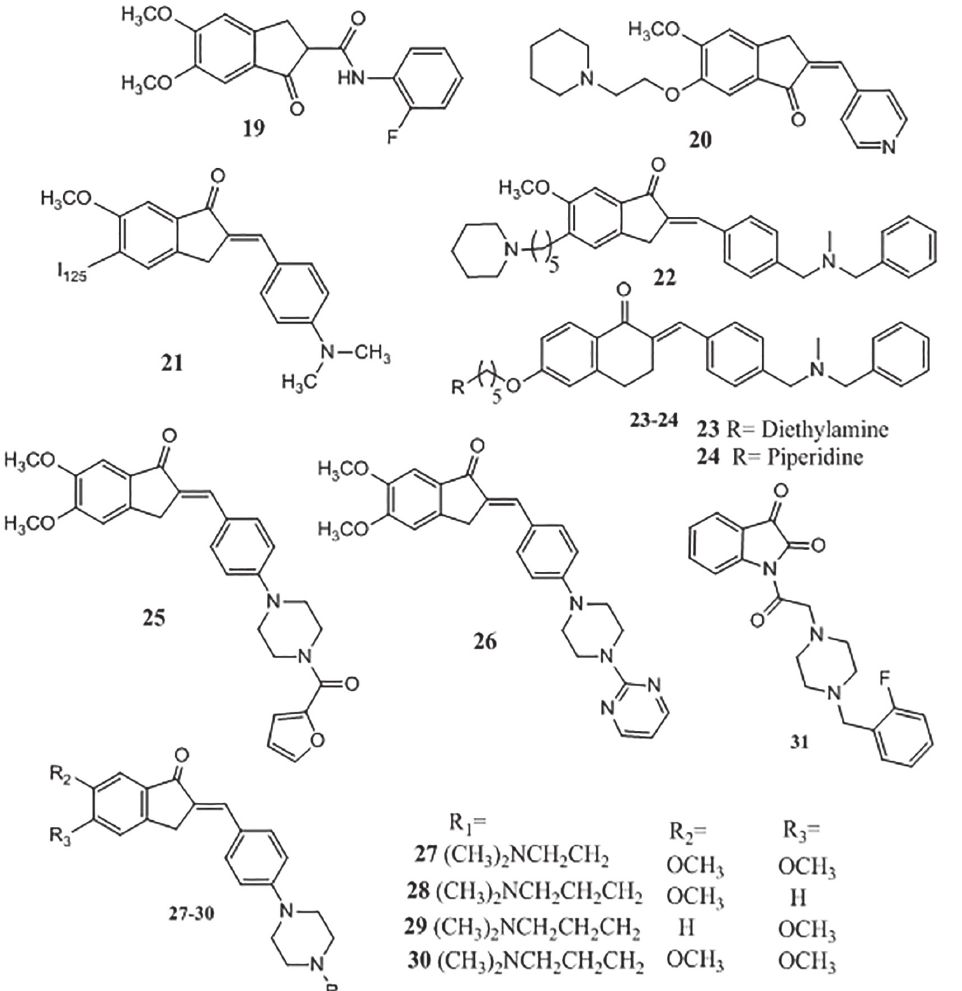
FIGURE 5 - Indanone derivatives having aromatic and heterocyclic